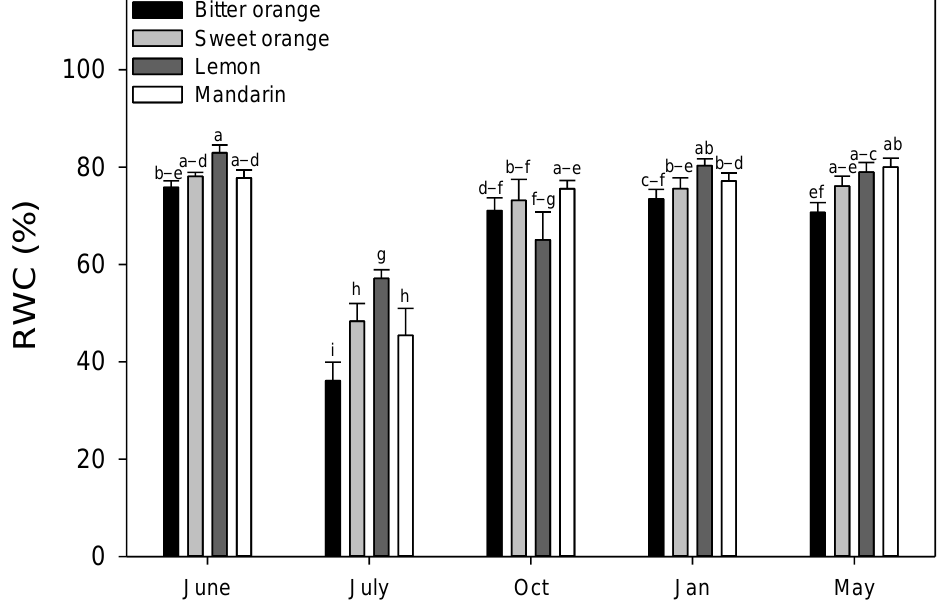
Figure 2. Seasonal variation of the relative water content (RWC %) in Citrus spp. leaves. Data are means ± standard error ( n = 5). Statistics as in Figure 1. Different lowercase letters indicate significant differences among means ( p ≤ 0.05, Fisher’s LSD).